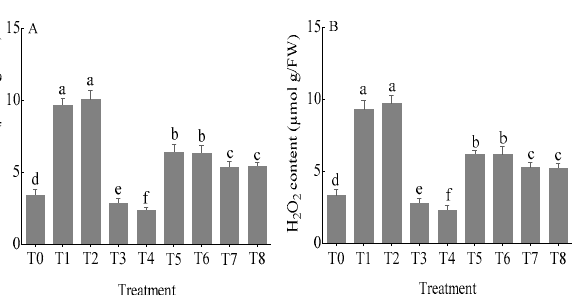
Figure 8. Effects of TL6 and TL13 treatment on ( A ) MDA and ( B ) H 2 O 2 in the leaves of snow pea plants under F. solani and F. avenaceum stress. Data are presented as mean ± standard errors (SE) of two independent experiments in three replicates. Means with the same lowercase letters are not significantly different at p < 0.05, according to Duncan’s multiple range tests.